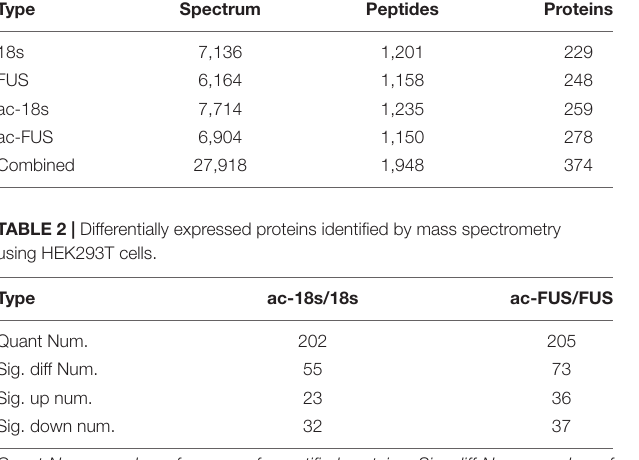
TABLE 1 | Number of proteins identified by mass spectrometry using HEK293T cells.